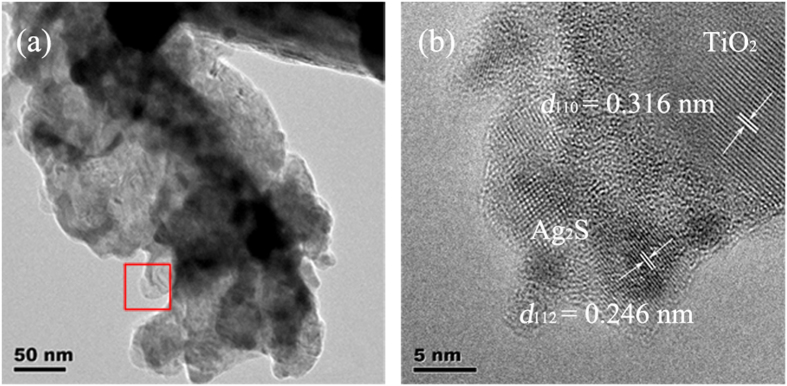
(a) TEM image and (b) the corresponding HRTEM image of Ag2S-coupled TiO2 NRAs by SILAR method for 35 cycles, corresponding to the rectangular region in (a).